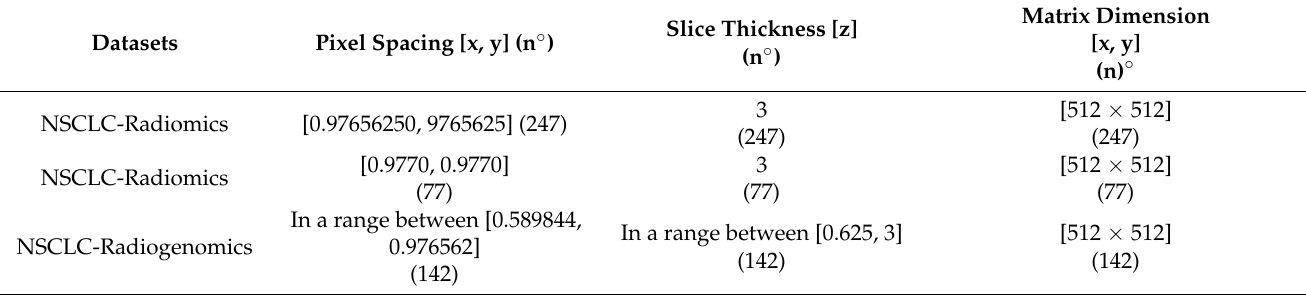
Table 3. The pixel spacing (mm), slice thickness (mm), and matrix dimension of each CT scan.